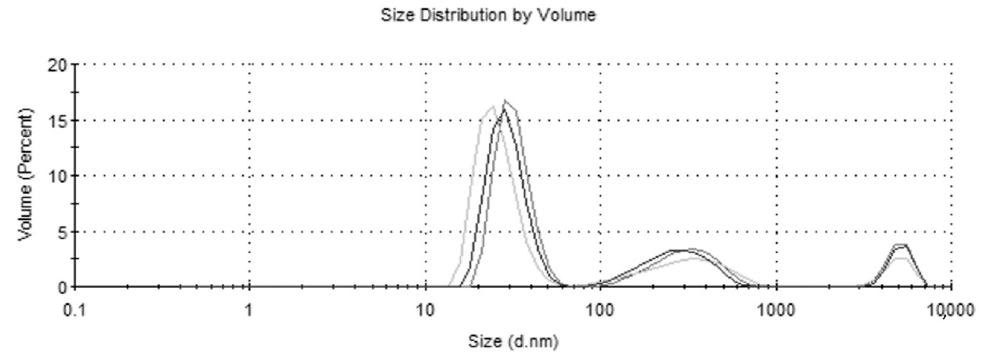
Figure 5. Size distribution graph of MMSC ECM nanoparticles. Sample was run three times and plotted in the figure above.